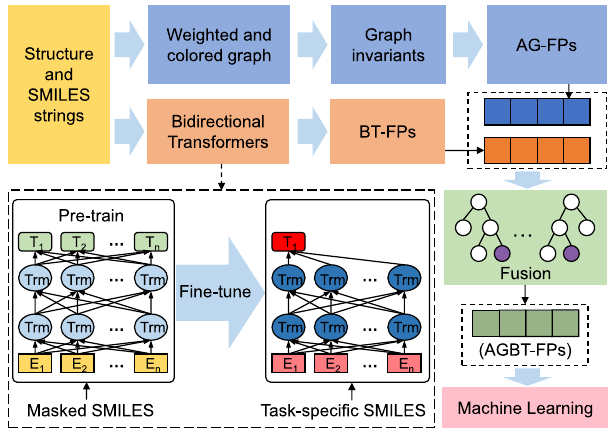
Fig. 1 Illustration of AGBT model. For a given molecular structure and its SMILES strings, AG-FPs are generated from element-speci fi c algebraic subgraphs module and BT-FPs are generated from a deep bidirectional transformer module, as shown inside the dashed rectangle, which contains the pre-training and fi ne-tuning processes, and then fi nally completes the feature extraction using task-speci fi c SMILES as input. Then the random forest algorithm is used to fuse, rank, and select optimal fi ngerprints (AGBT-FPs) for machine